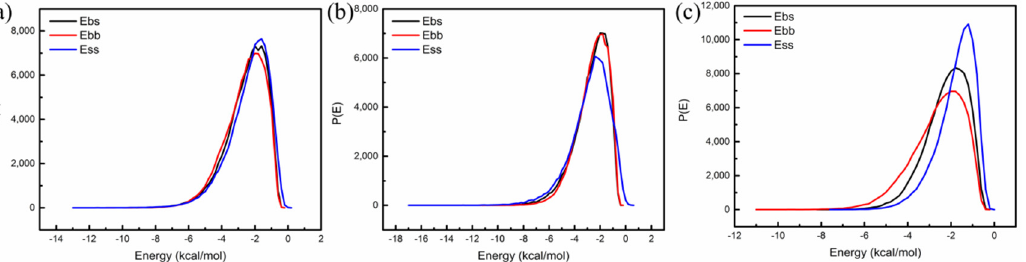
Figure 8. The probability distribution of mixing energy of nano-OvPOSS with SBS: ( a ) 5 Å nano-OvPOSS; ( b ) 7 Å nano-OvPOSS; ( c ) 9 Å nano-OvPOSS.